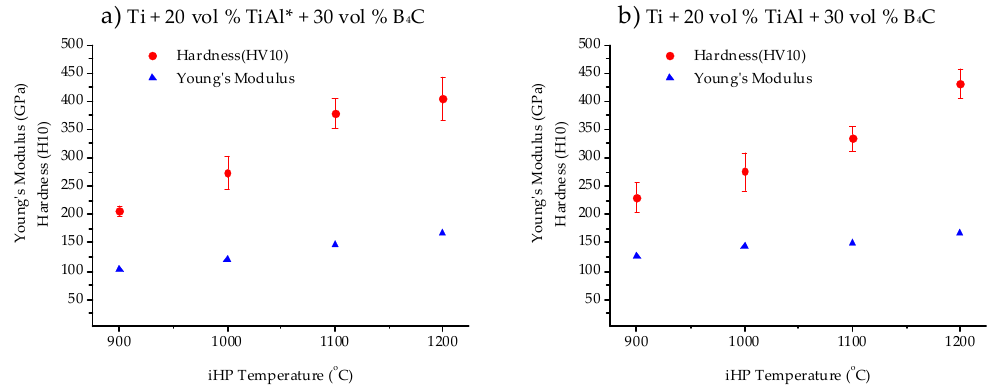
Figure 10. (All the specimens consolidated at 80 MPa). Processing temperature (°C) vs. hardness (HV10) and Young’s Modulus (GPa): ( a ) Ti + 20 vol % TiAl* + 30 vol % B 4 C; ( b ) Ti + 20 vol % TiAl + 30 vol % B 4 C.